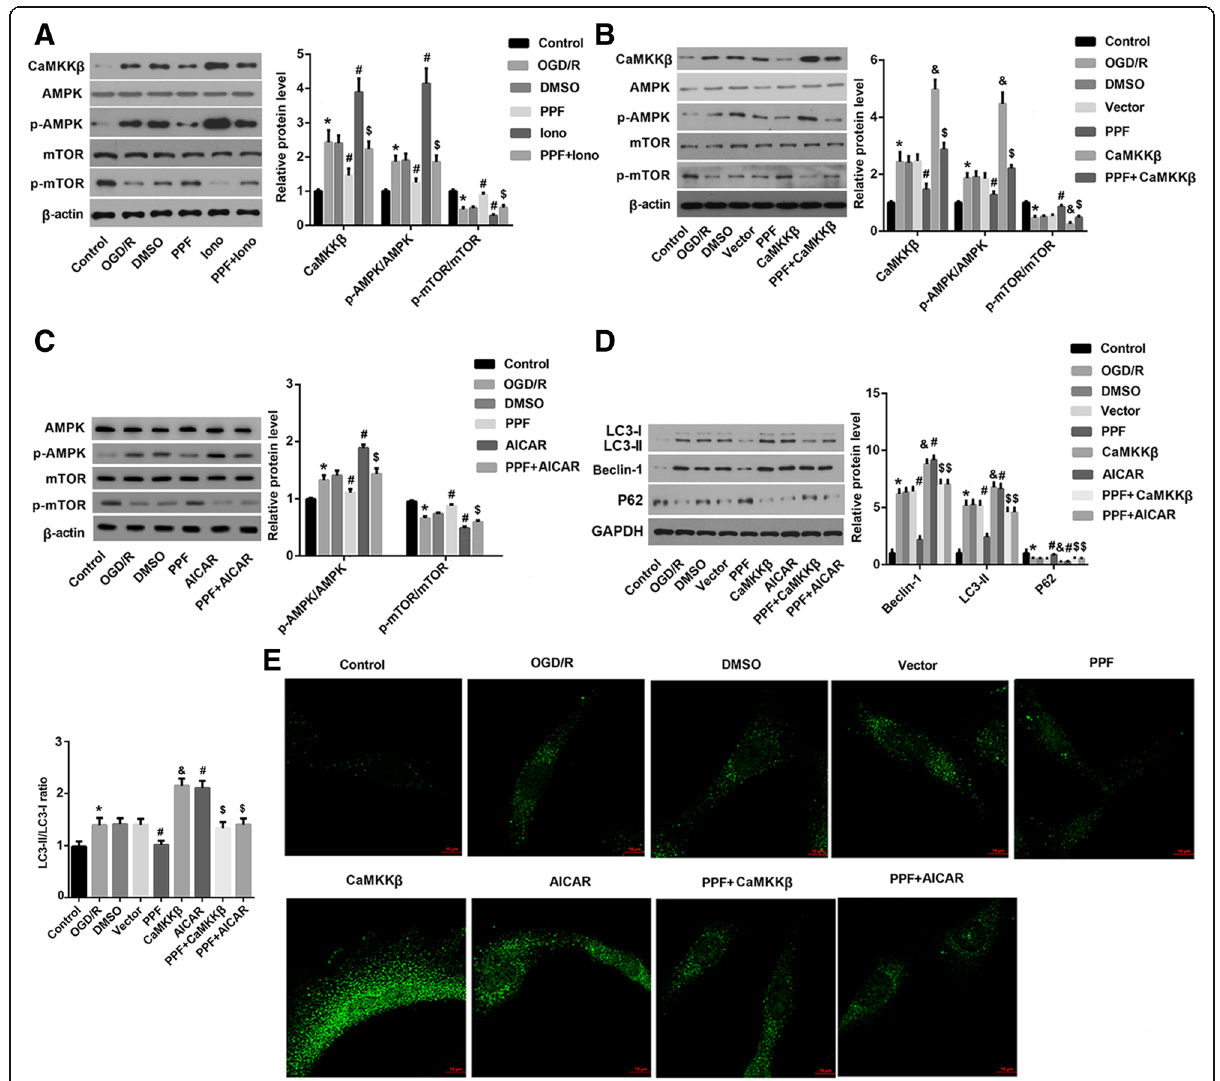
Fig. 6 Ca 2+ /CaMKK β /AMPK/mTOR signaling was involved in the PPF-mediated suppression of autophagy. a Western blot was performed to evaluate the effects of [Ca 2+ ]i elevator ionomycin (iono) on the PPF-mediated regulation of CaMKK β , AMPK, p-AMPK, mTOR, and p-mTOR. b Western blot was performed to investigate the effects of overexpression of CaMKK β on the PPF-mediated regulation of CaMKK β , AMPK, p-AMPK, mTOR, and p-mTOR. c Western blot was performed to investigate the effects of activation of the AMPK pathway by AICAR on the PPF-mediated regulation of CaMKK β , AMPK, p-AMPK, mTOR, and p-mTOR. d Western blot was performed to investigate the effects of activation of CaMKK β / AMPK/mTOR pathway on the PPF-mediated suppression of autophagy-related proteins. e GFP-LC3 immunofluorescence was performed to evaluate the effects of activation of activation of CaMKK β /AMPK/mTOR pathway on the PPF-mediated suppression of autophagy level. Scale bar: 10 μ m. Values are represented as the mean ± SD from three independent experiments. * p < 0.05 vs. Control group; # p < 0.05 vs. DMSO group; & p < 0.05 vs. vector group; $ p < 0.05 vs. PPF